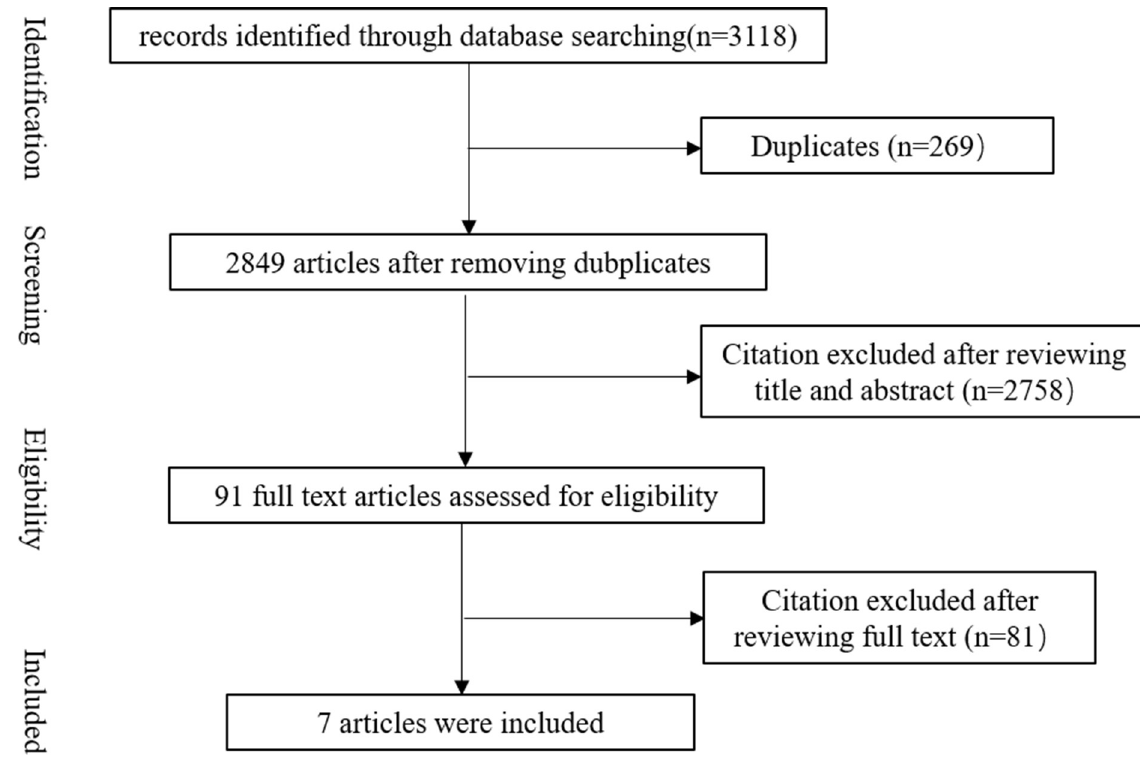
Fig 1. Flow chart of selection